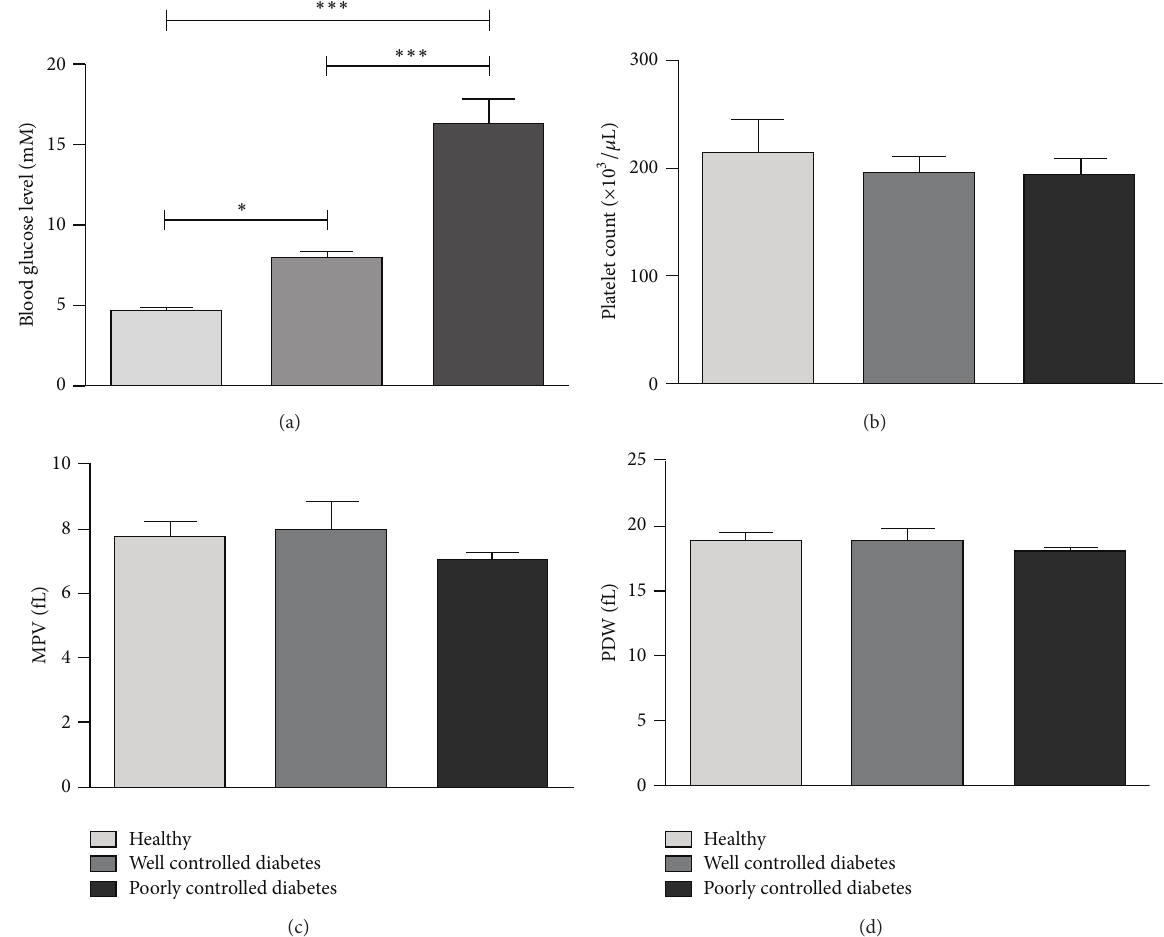
Figure 1: Haematological parameters for healthy and diabetic monkeys. (a) Blood glucose, (b) platelet count, (c) mean platelet volume, and (d) platelet distribution width. Data are from six monkeys in each group. ∗ 𝑃 < 0.05 , ∗∗∗ 𝑃 < 0.001